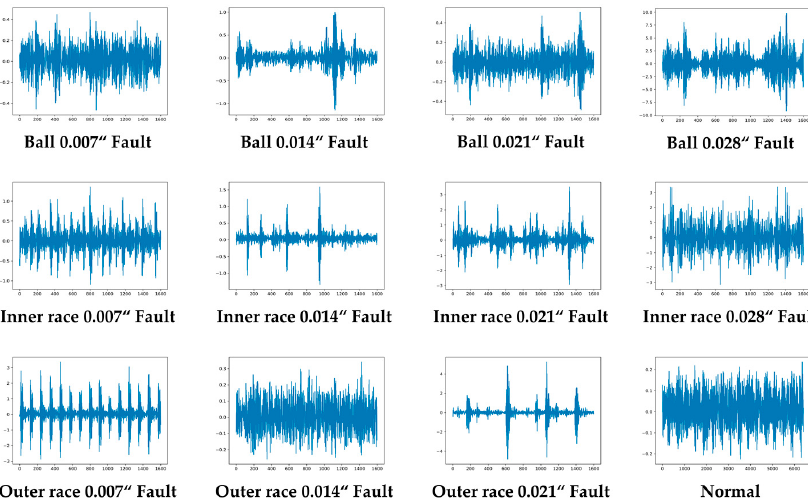
Figure 6. Samples of raw vibration sensor signals corresponding to each class.